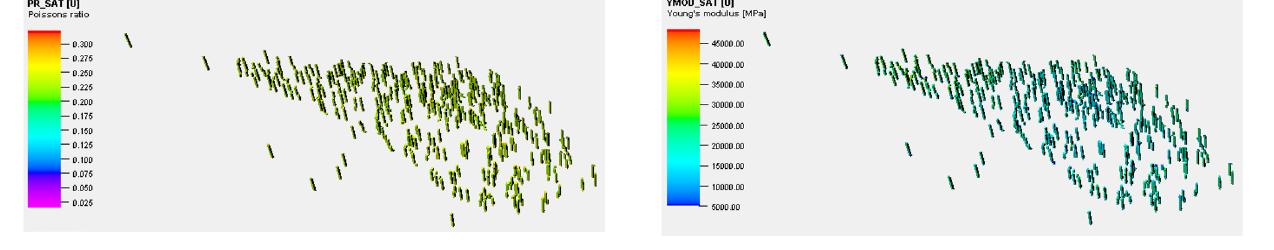
Fig. 12 Longitudinal discretization of Poisson's ratio Fig. 13 Longitudinal discretization of Young's